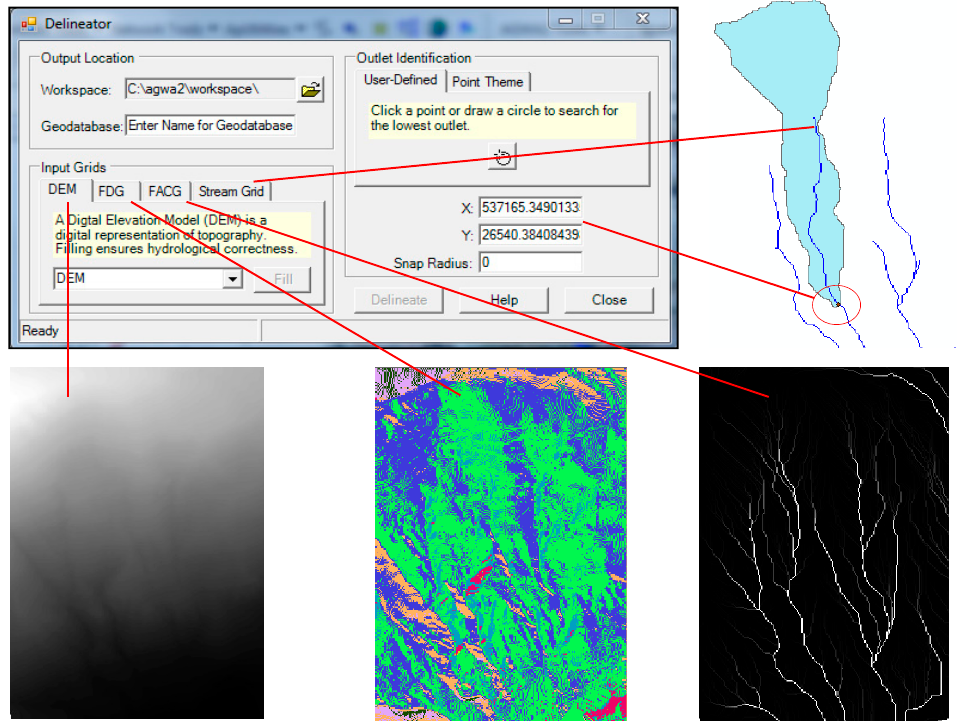
Figure 3. (From left to right and from top to bottom). KINEROS 2 delineator interface, basin boundary and streams, Digital Elevation Model, flow direction grid and flow accumulation grid (images without scale) [3].